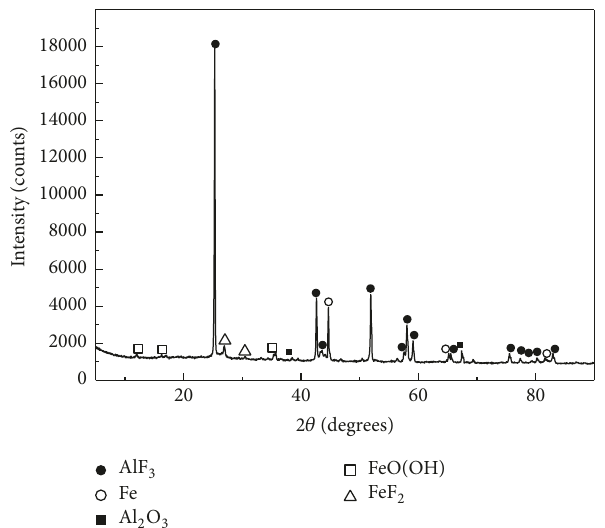
Figure 10: XRD results of type B materials after drop-weight test.